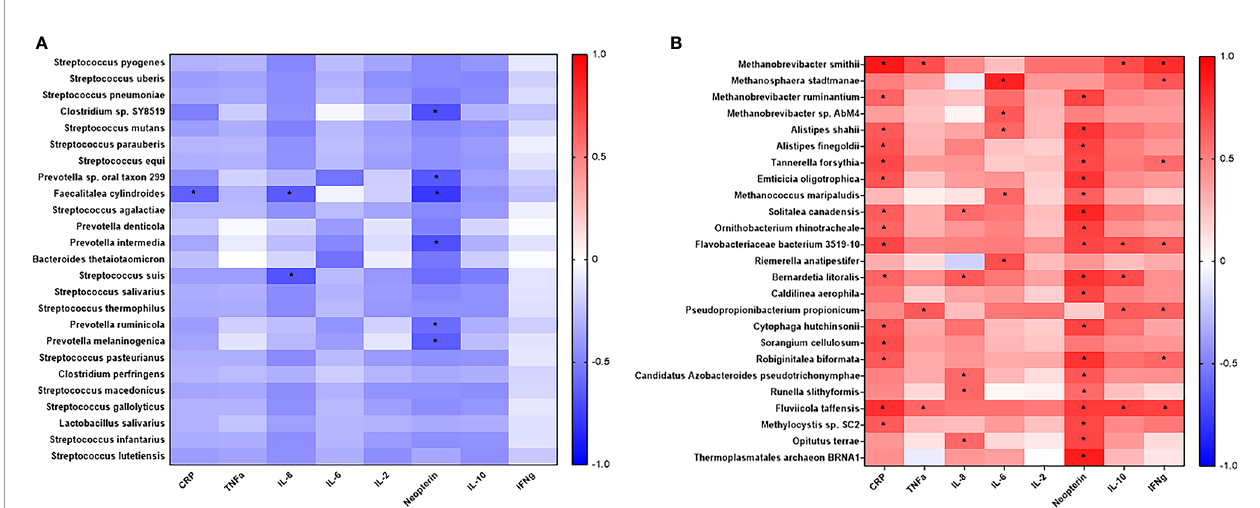
FIGURE 5 | Correlation analysis of prevalent microbes in young adult or geriatric Rhesus Macaques and plasma in fl ammatory cytokines: Microbes were selected based off increased prevalence in young adult (A) or geriatric (B) rhesus macaques and then correlated with plasma cytokines. Positive correlations are in red. Negative correlations are in blue. Statistical differences are identi fi ed by *. Geriatric animals showed signi fi cantly more correlations with plasma cytokines, all of which were positive correlations. The list of bacteria and cytokines were derived from a Benjamini-Hochberg FDR corrected list. Test of signi fi cance for this analysis was a simple 2-tailed t-test for the